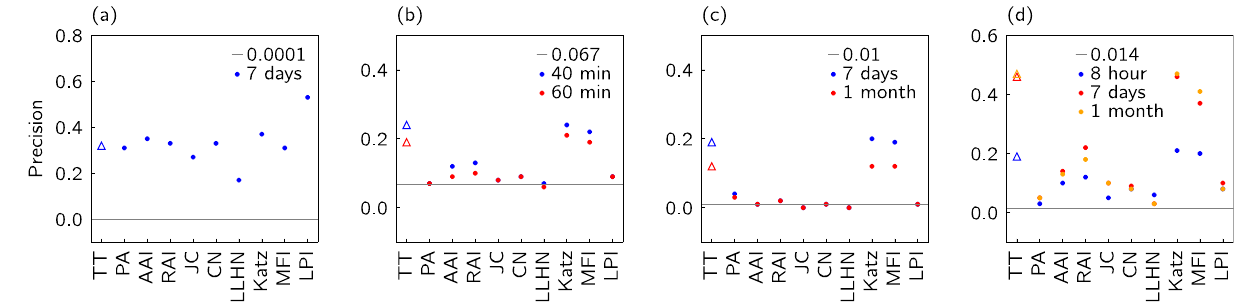
Figure 8. Precision scores for the link prediction results for ten algorithms applied to four temporal networks constructed from real data sets: ( a ) Turkish Shareholder networks, ( b ) Hypertext networks, ( c ) College Message networks, ( d ) Email networks. Results for the Triad Transition algorithm based on transition matrix denoted by the triangle symbol (cid:31) . For the networks in ( b – d ), we also show the results for different time scales (window). See Table 2 for abbreviations used in indicate link prediction methods.